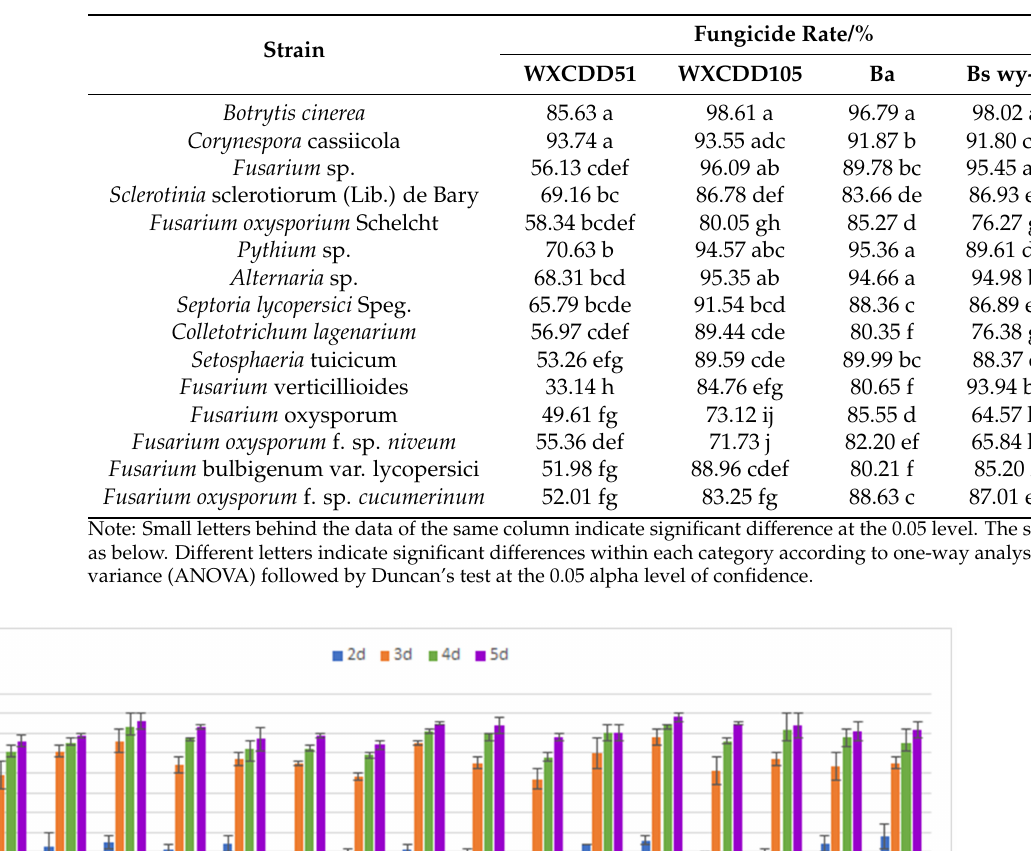
Table 1. Fungicide rate of four biocontrol bacteria.